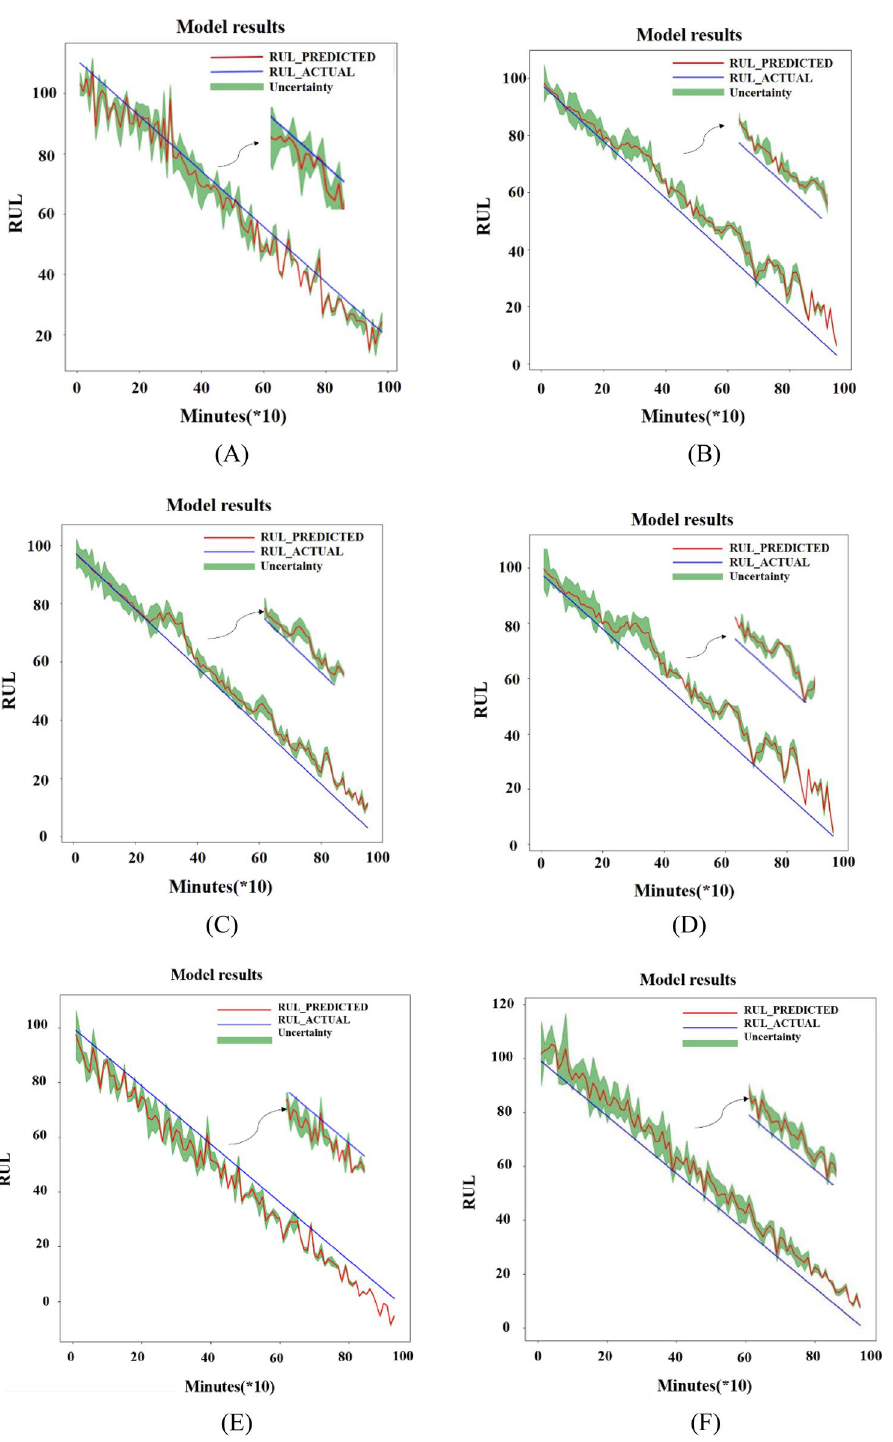
Figure 16. Visualization of RUL prediction results of different comparison algorithms. ( A ) Transformer; ( B ) RNN; ( C ) LSTM; ( D ) GRU; ( E ) 1-D CNN; ( F ) CNN-LSTM; ( G ) RF; ( H ) SVM; ( I ) SAE-LSTM; ( J )